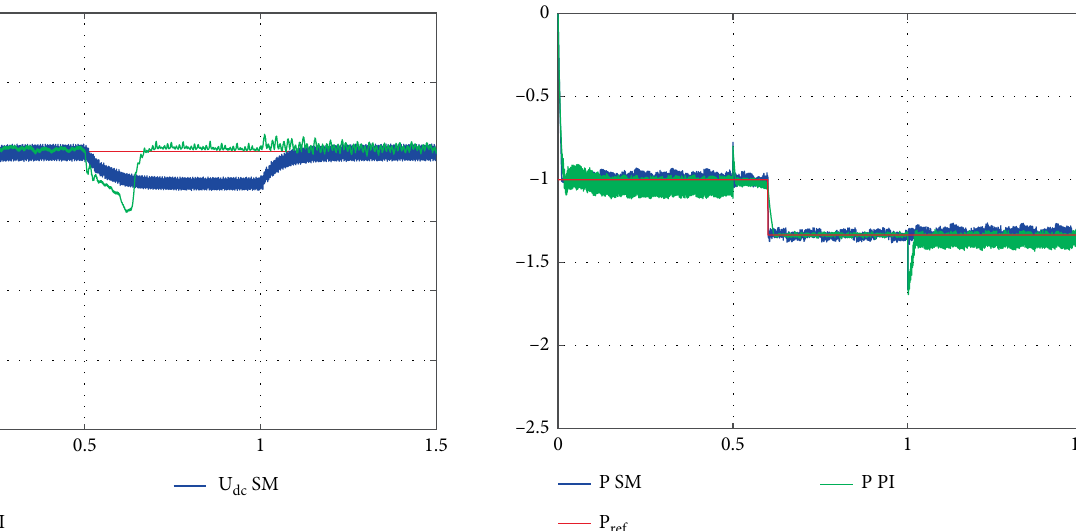
Figure 14: DC BUS voltage with 20% depth of stator voltage.